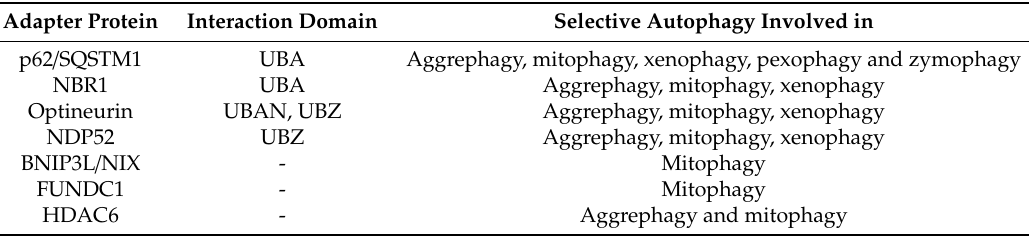
Table 2. Selective autophagy